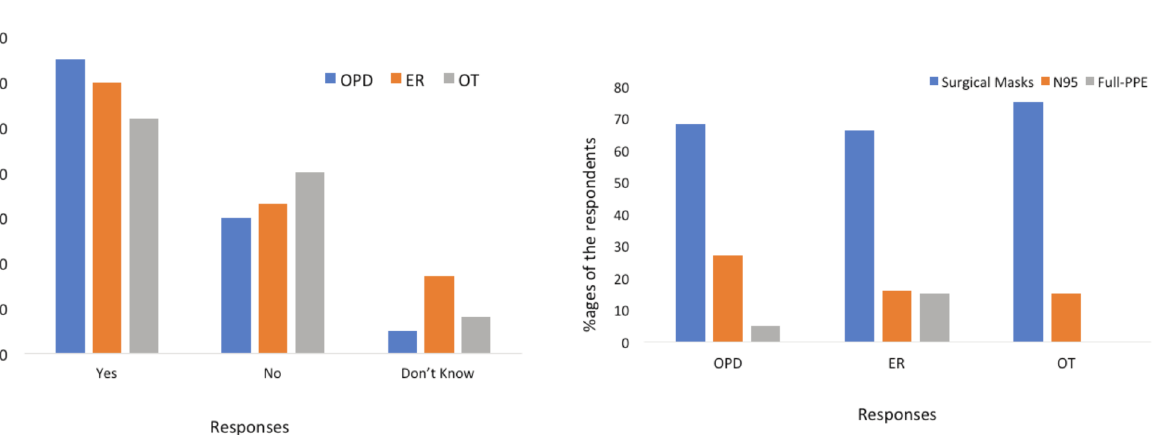
Bar graph showing percentage of respondents using Fig. 3: various safety measures like only surgical masks, N95 respirator and full personal protective equipment (PPE) in outpatient departments (OPD), emergency (ER) and operation theatres